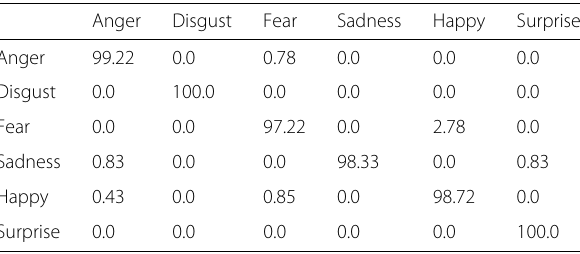
Table 12 Confusion matrix of DTCTH in case of 6-class expression recognition on CK